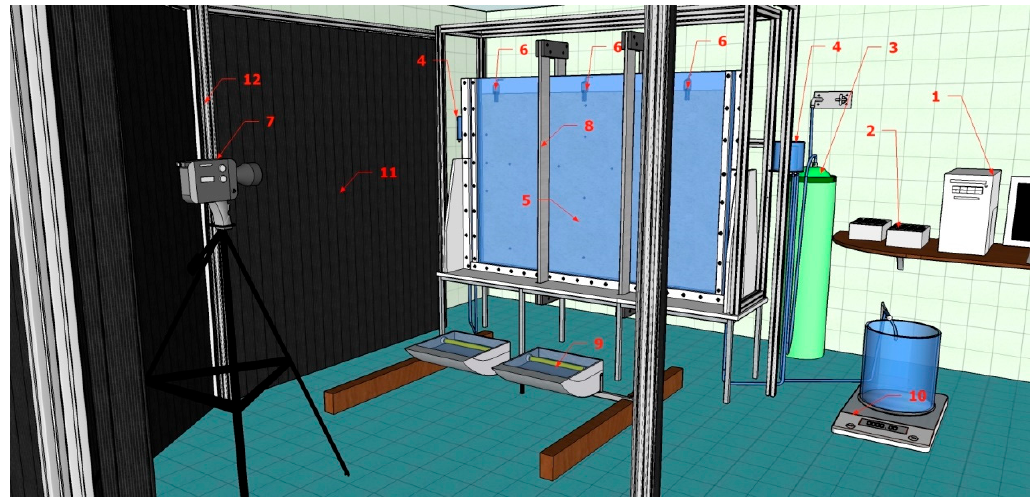
Figure 1. Schematic representation of the experimental setup: ( 1 ) computer (softwares: Keysight VEE, ImageJ, Nikon Camera Control); ( 2 ) data logger; ( 3 ) water purification system (Veolia-Aquadem); ( 4 ) 2 overflow outlets (can be moved along the vertical axis); ( 5 ) Plexiglas flow tank (180 cm × 120 cm × 4 cm); ( 6 ) 3 theta probes ML2x; ( 7 ) NIKON digital camera D80; ( 8 ) aluminum stiffening bars; ( 9 ) floodlight (400 W); ( 10 ) Sartorius digital balance; ( 11 ) black curtain (all around the experiment); ( 12 ) Norcan metallic structure).